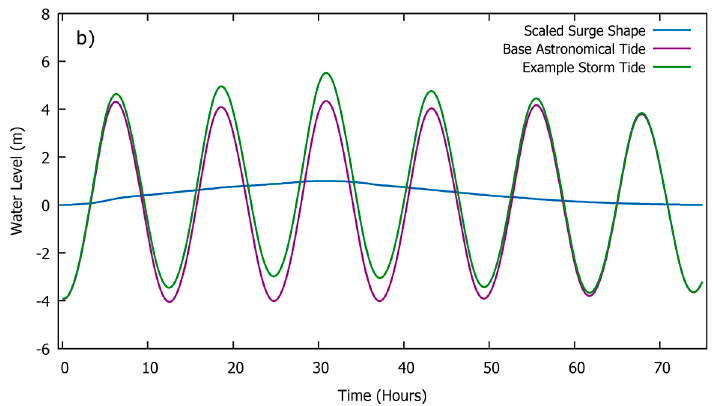
Figure 4. An example the ( a ) storm profile and ( b ) surge profile [51] of the base astronomical tide and storm tide at Carmarthen Bay. Table 2. Peak storm water levels in Carmarthen Bay, determined following McMillan et al. [51].